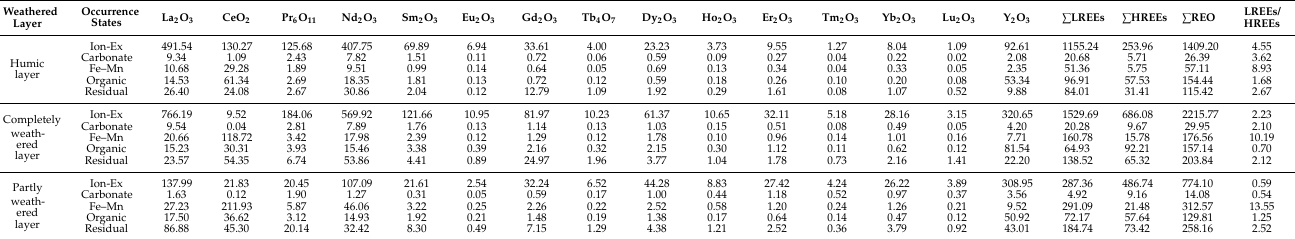
Table 2. Rare earth concentrations in different occurrence states/ µ g · g − 1